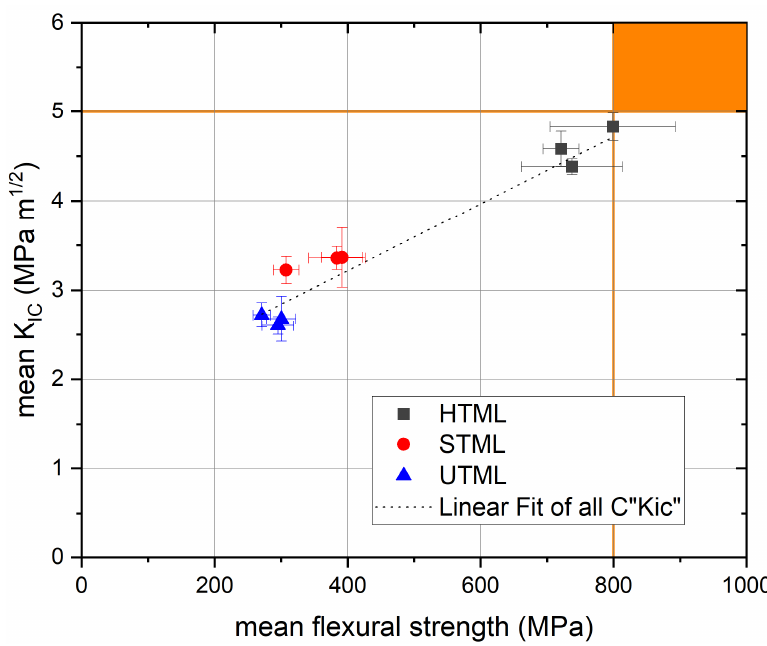
Figure 5. K IC vs. Bending strength ( σ b ) for Katana HTML–STML–UTML multilayer ceramics based on Filser et al. [2]. The right upper corner in orange presents the range for unlimited indication.